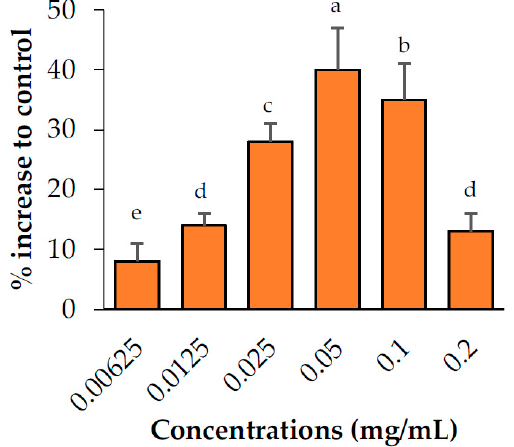
Figure 2. Lipolysis enhancement activity of the candidate plant extracts. Isoproterenol (ISP, positive control) was used at 2.5 µM. Data are expressed as means ± standard deviation. Means with different letters are significantly different (Tukey’s test, p < 0.05).